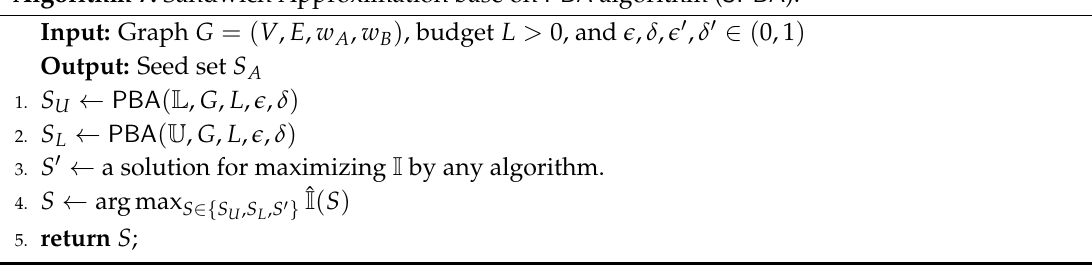
Algorithm 7: Sandwich Approximation base on PBA algorithm ( SPBA